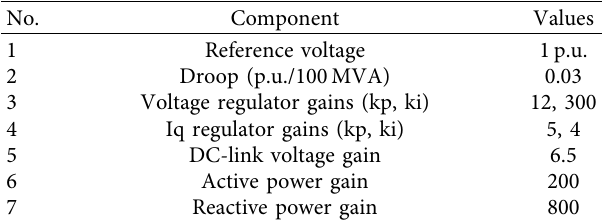
Table 7: Parameter values of STATCOM